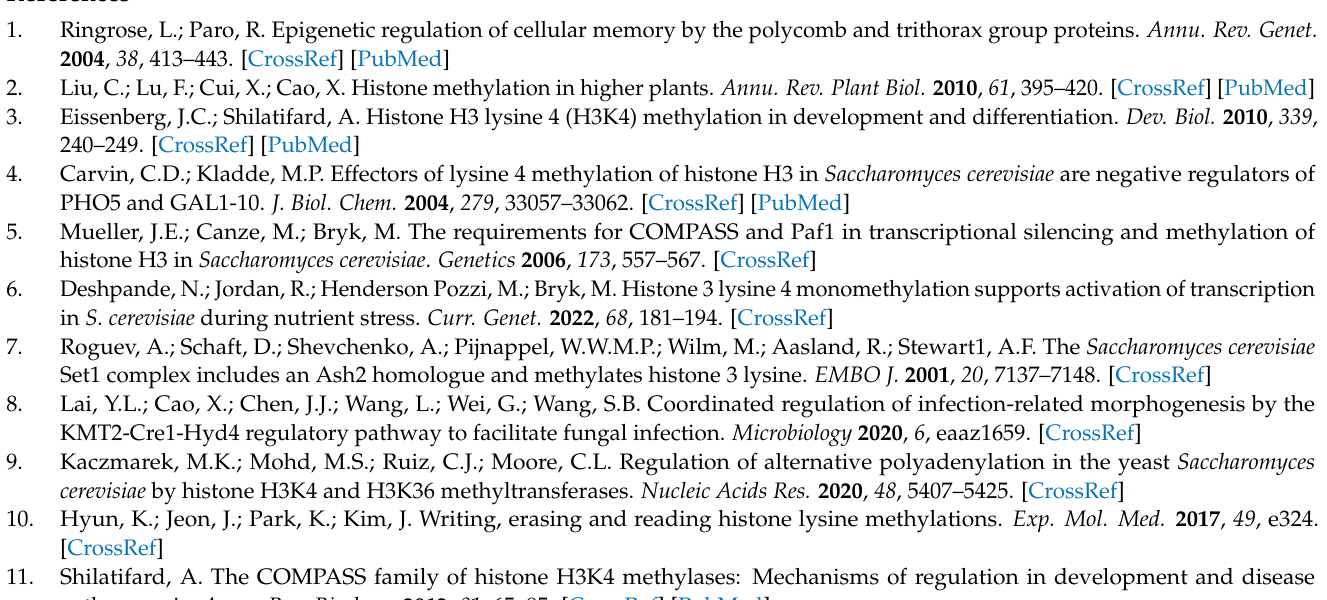
Table S1. Primers used in this study. Table S2. Genes marked by H3K4me3 modification. Table S3. Up-regulated genes in the ∆ Uvkmt2 mutant. Table S4. Down-regulated genes in the ∆ Uvkmt2